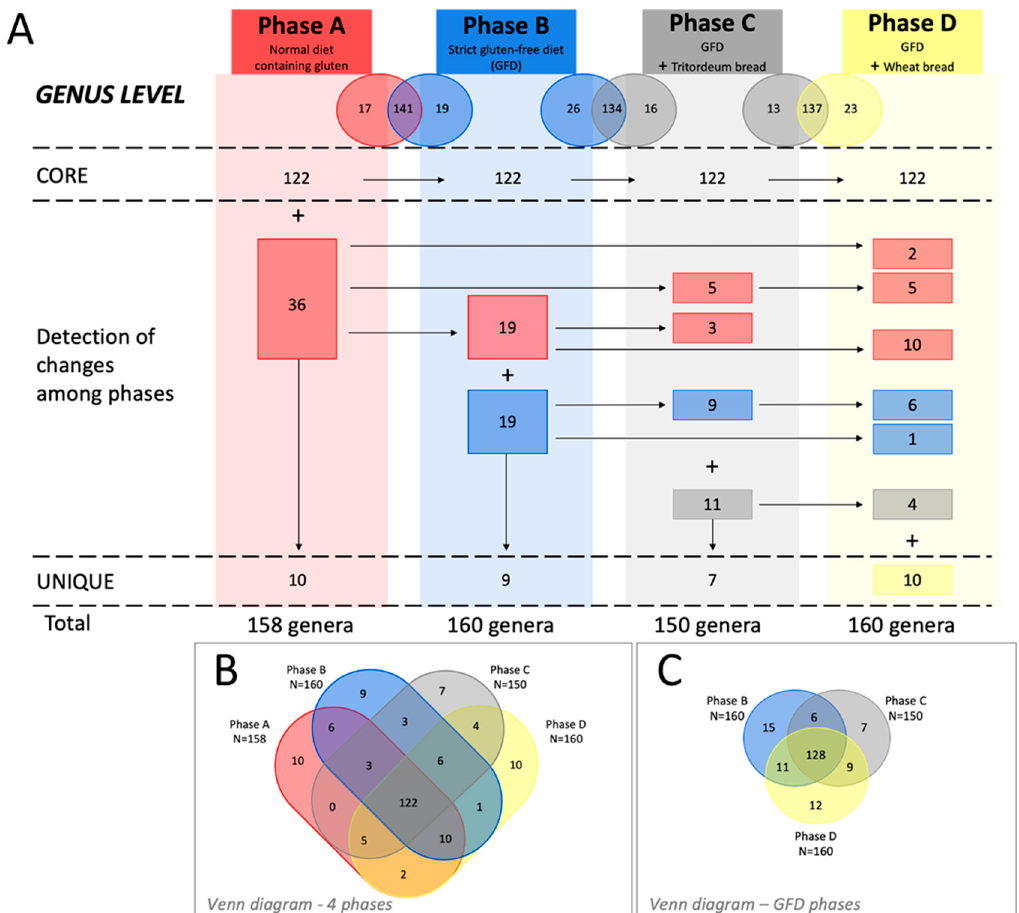
Figure 8. ( A ) Characterization of the temporal dynamics of the human gut microbiome throughout the four study phases at the genus level. ( B ) Venn diagram of the four phases of study. ( C ) Venn diagram of the three phases with a GFD. Each phase is represented with a color: red for phase A, blue for phase B, gray for phase C and yellow for phase D. The numbers that are represented in colored squares mean the number of genera that has been detected for the first time in the phase represented with the same color and the horizontal arrows represent the genera that are maintained from one phase to another.